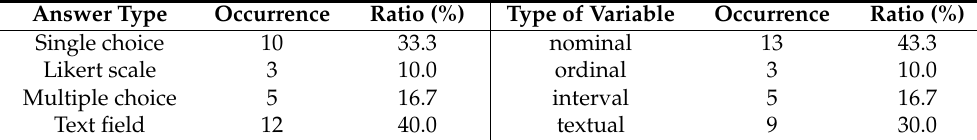
Table 2. Survey questions according to the answer type and type of